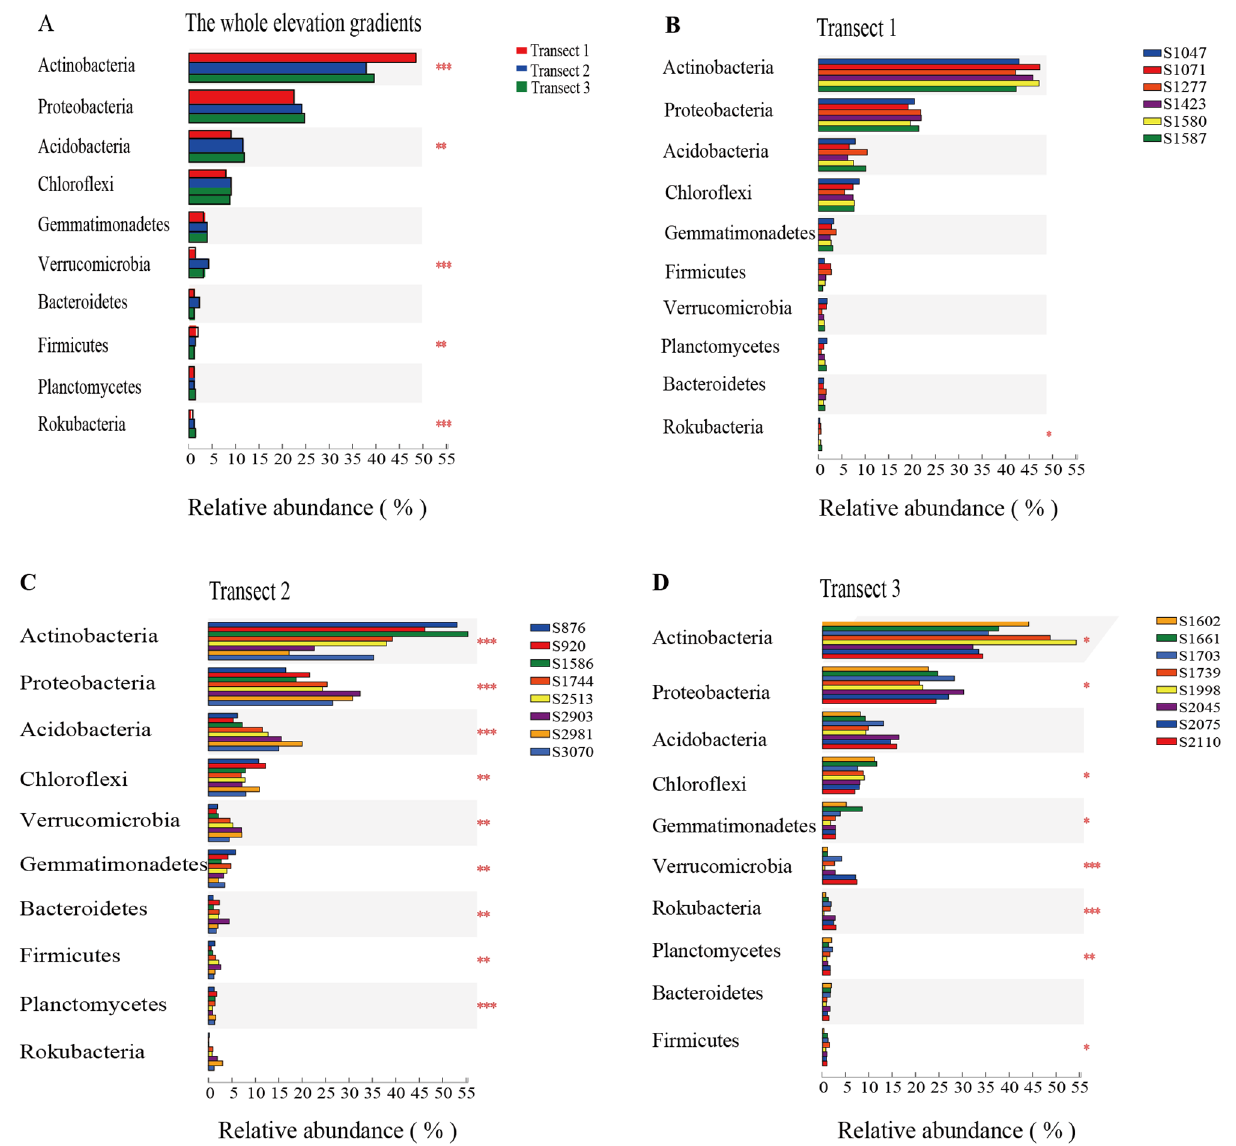
Figure 2. Bacterial community composition variations at the phylum level in different Transects and elevation sites. The vertical axis denotes phylum name, while the horizontal axis represents the average relative abundance in samples from different elevations, and differently colored columns represent different elevation sites. P values (one-way ANOVA) are marked on the right side of the graph, * P < 0.05, ** P < 0.01, *** P < 0.001. These were done in R (v3.3.1, http:// www.R- proje ct.